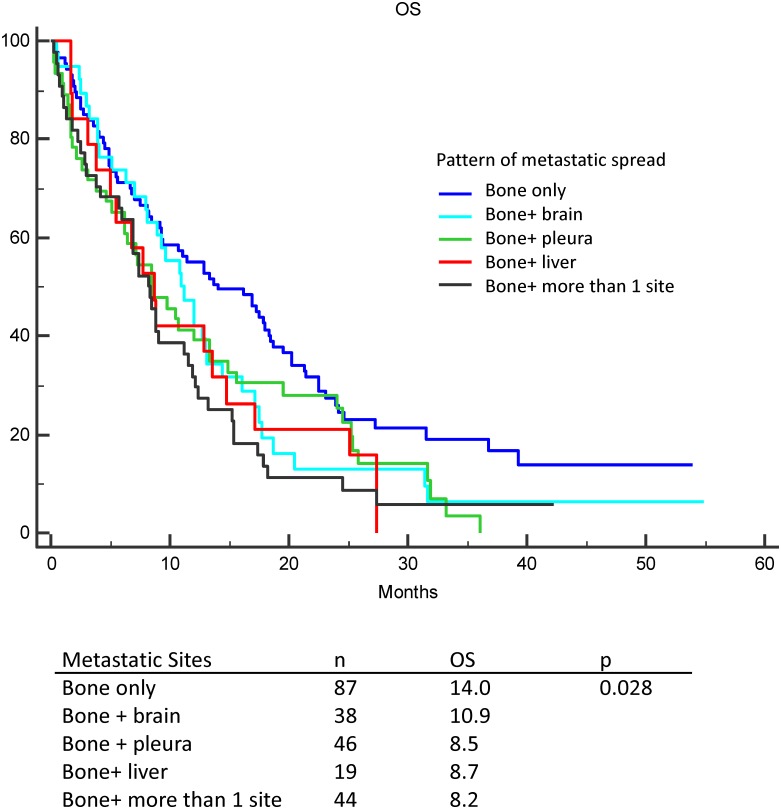
Kaplan-Meier curve for overall survival according to patterns of metastatic spread.Patients with bone metastases only had longer OS duration than those concomitant with other metastatic sites. (p = 0.028)